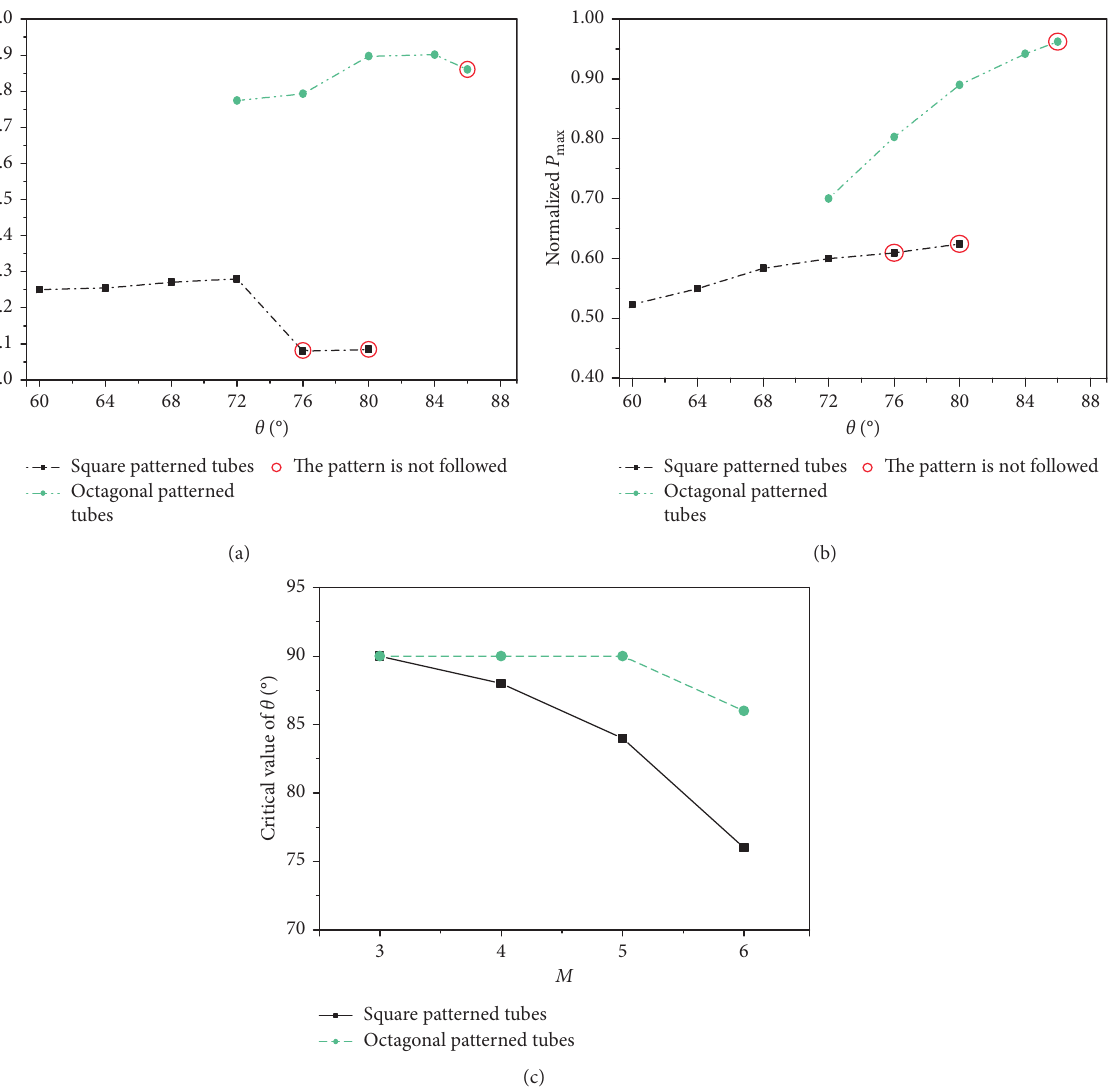
Figure 14: Relationship between the (a) normalized SEA and θ , (b) normalized P octagonal tubes with